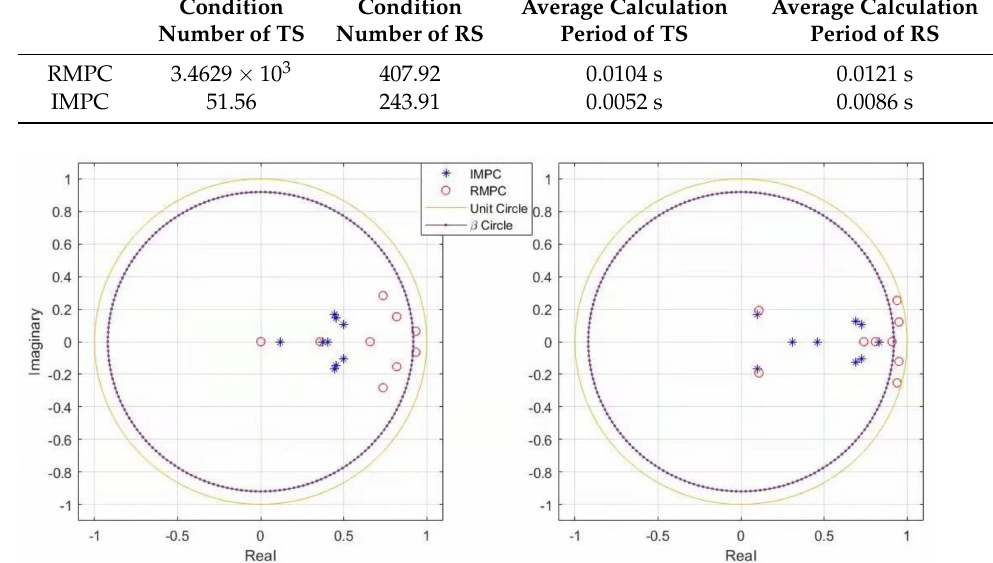
Figure 10. Poles of closed-loop system for the TS ( left ) and RS ( right ). The poles of the closed loop of IMPC are closer to the center of the unit circle than those of RMPC, which means the dynamic of IMPC is better than that of RMPC.